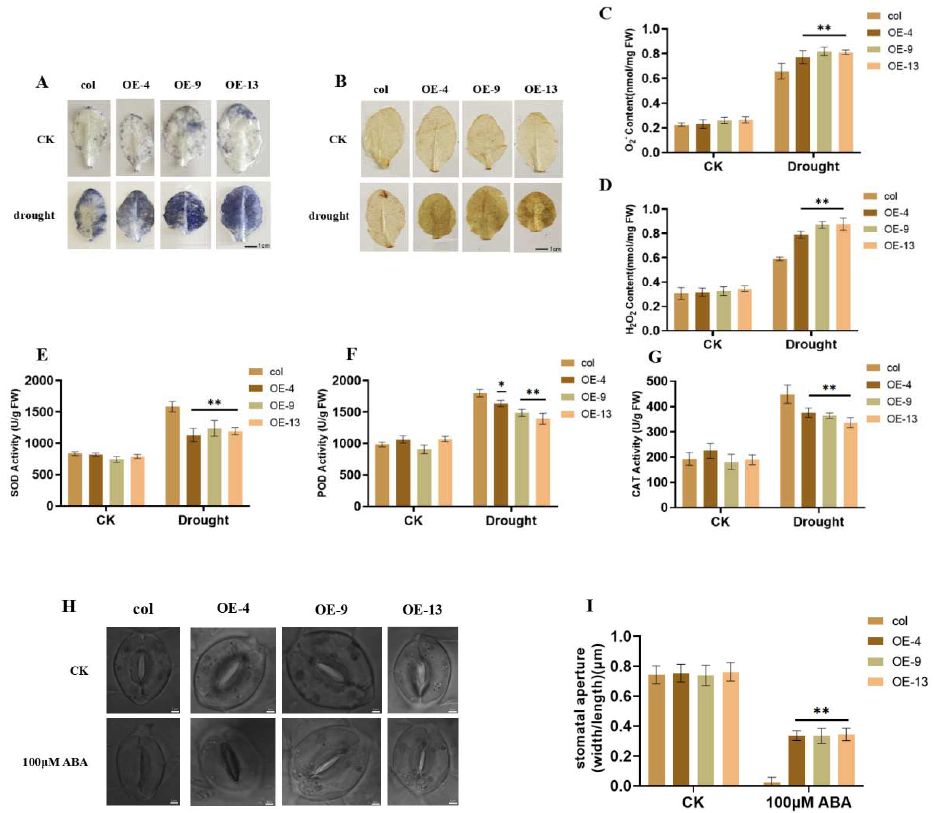
Figure 5. Reactive oxygen species staining and physiological indices in ZmGST26-overexpressing Arabidopsis plants. ( A , B ) NBT and DAB staining of leaves for H2O2 from ZmGST26 transgenic seedlings and wild-type plants under normal conditions and drought stress. ( C , D ) Accumulation of H 2 O 2 and O 2- in leaves of diferent lines. ( E ) SOD content. ( F ) POD content. ( G ) CAT content. ( H , I ) Stomatal aperture of transgenic Arabidopsis under 100μM ABA treatment. * p < 0.05; ** p < 0.01. All bars represent means ± SD, (n ≥ 3).